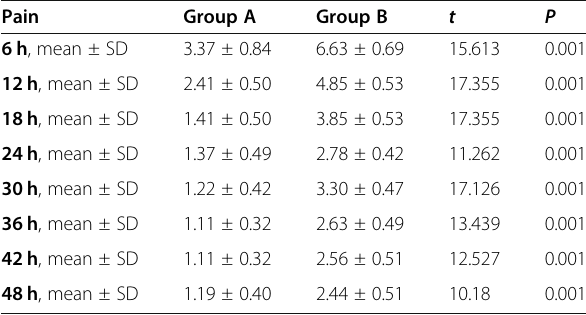
Table 4 Comparison between the two groups regarding Bromage scale score at day one and day two from operation